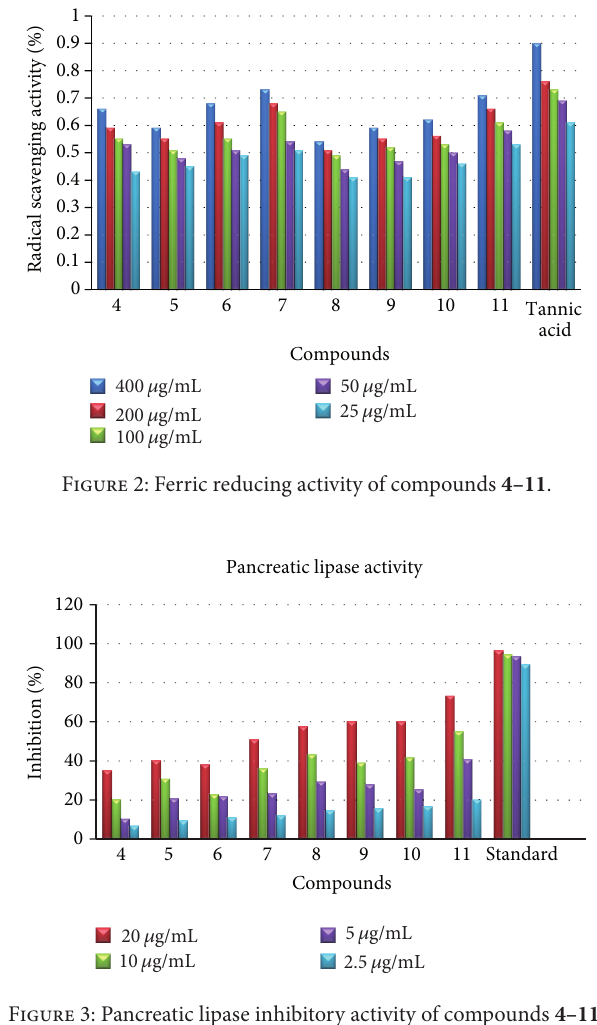
F 1: DPPH radical scavenging activity of compounds 4–11 .